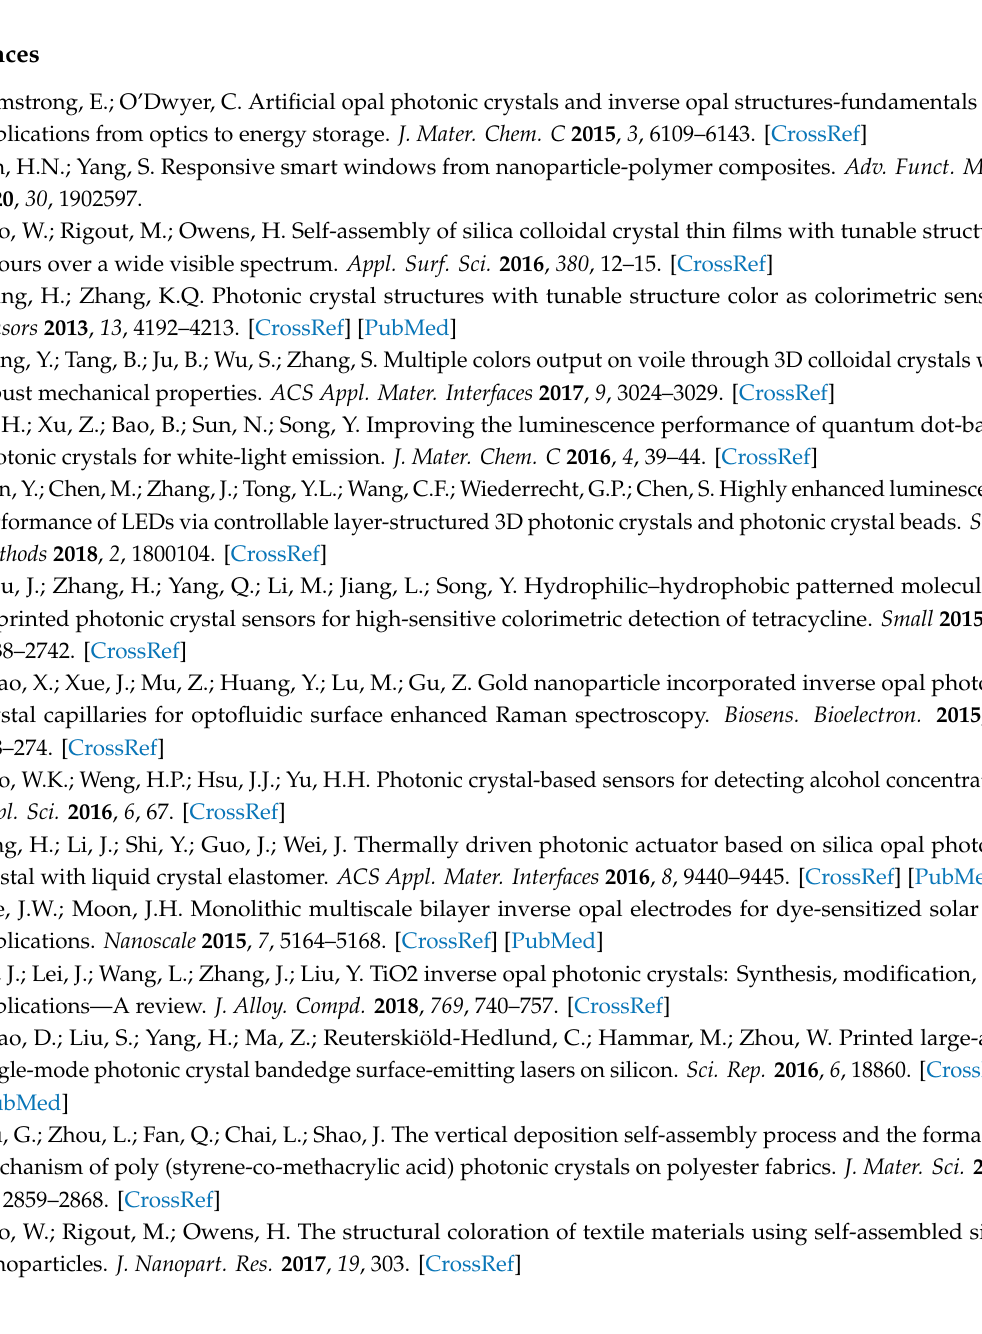
Figure S1: Photos of PC films prepared by silica with particle size of ( A ) 200 nm and ( B ) 356